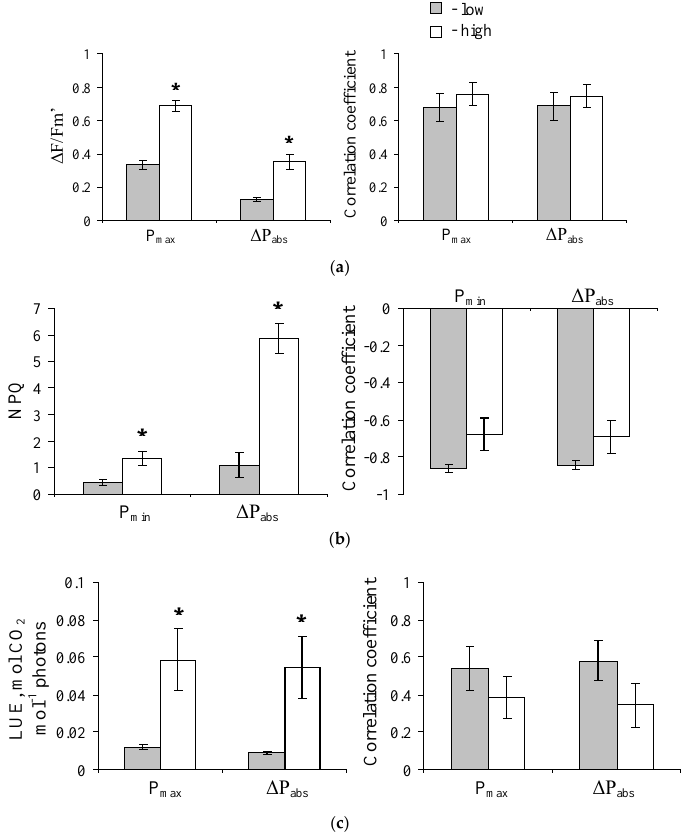
Figure 5. The influence of the distribution of ∆ F/F m ’ ( a ); NPQ ( b ) and LUE ( c ) on investigated plants for the connection between these photosynthetic parameters with PRI at measurements of the photochemical reflectance index in canopy. Average values of P min (P max ) and ∆ P abs are shown on left panels, average correlation coefficients are shown on right panels. The label “low” indicates groups with low P min (P max ) and ∆ P abs ; the label “high” indicates groups with high P min (P max ) and ∆ Pabs . “Low” groups had n = 12 ( ∆ F/F m ’), n = 6 (NPQ), and n = 24 (LUE); “high” groups had n = 12 ( ∆ F/F m ’), n = 6 (NPQ), and n = 24 (LUE). * the group significantly differed from another one ( p < 0.05, Student’s